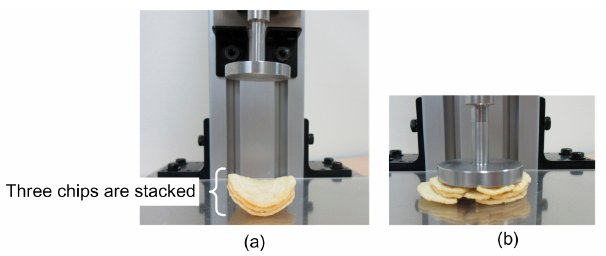
Figure 5. Images of stacked potato chips under equipment evaluation: ( a ) Three stacked potato chips